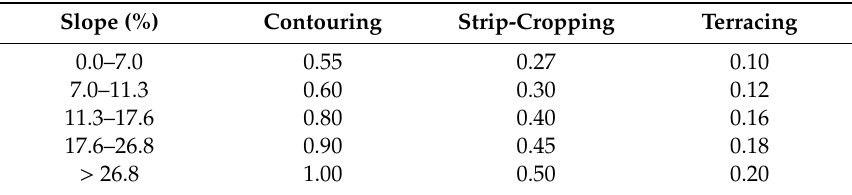
Table 4. P factor under di ff erent conservation support practices